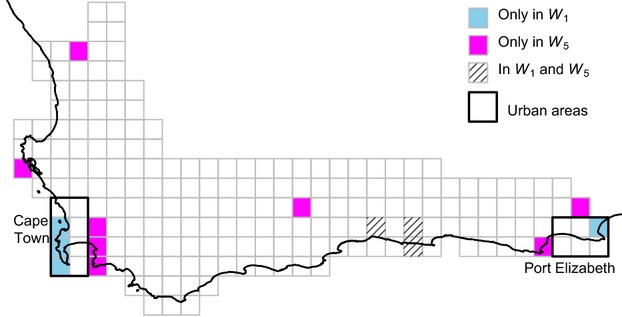
QDS selected to conserve 95% of split diversity under uniform conservation cost (W1) and under prioritization of rural areas (W5).